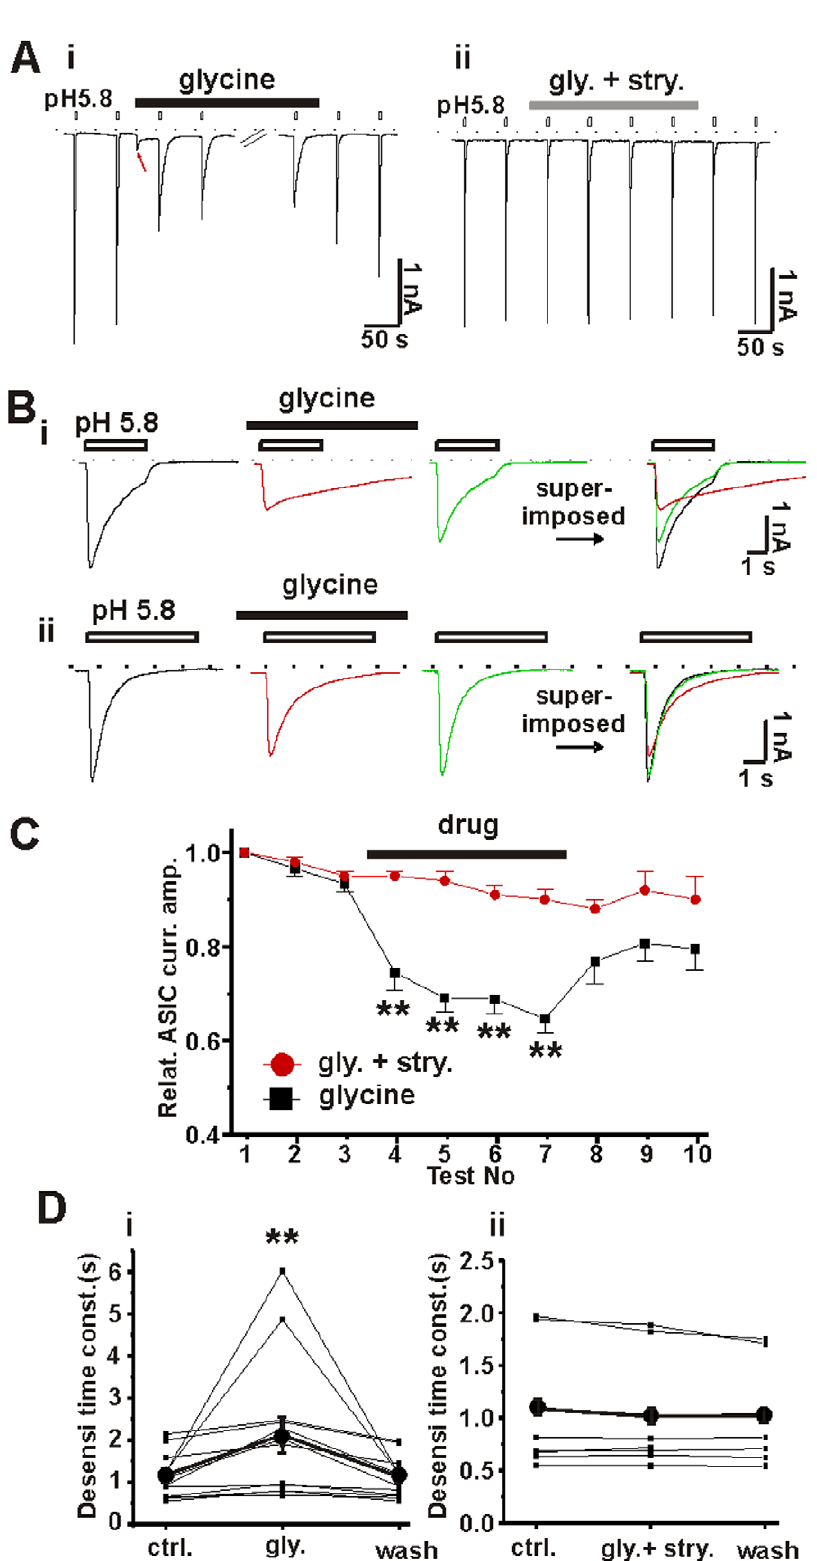
Figure 5. Activation of glycine receptors modifies ASICs in spinal neurons. A, representative traces of ASIC currents (elicited by pH 5.8) recorded in cultured primary spinal neurons. Application of glycine (500 m M) reversibly attenuated ASIC currents (i) and strychnine (10 m M) abolished the effect of glycine on ASICs (ii). Red arrow indicates the glycine-evoked current, which desensitized and remained small in the presence of glycine. Dashed lines indicate the position of zero current. B, two representative current traces (i & ii from different spinal neurons) showing the variable effect of glycine. Glycine had dramatic effect on desensitization kinetics and current amplitude of ASICs in some spinal neurons (example i) but had weak